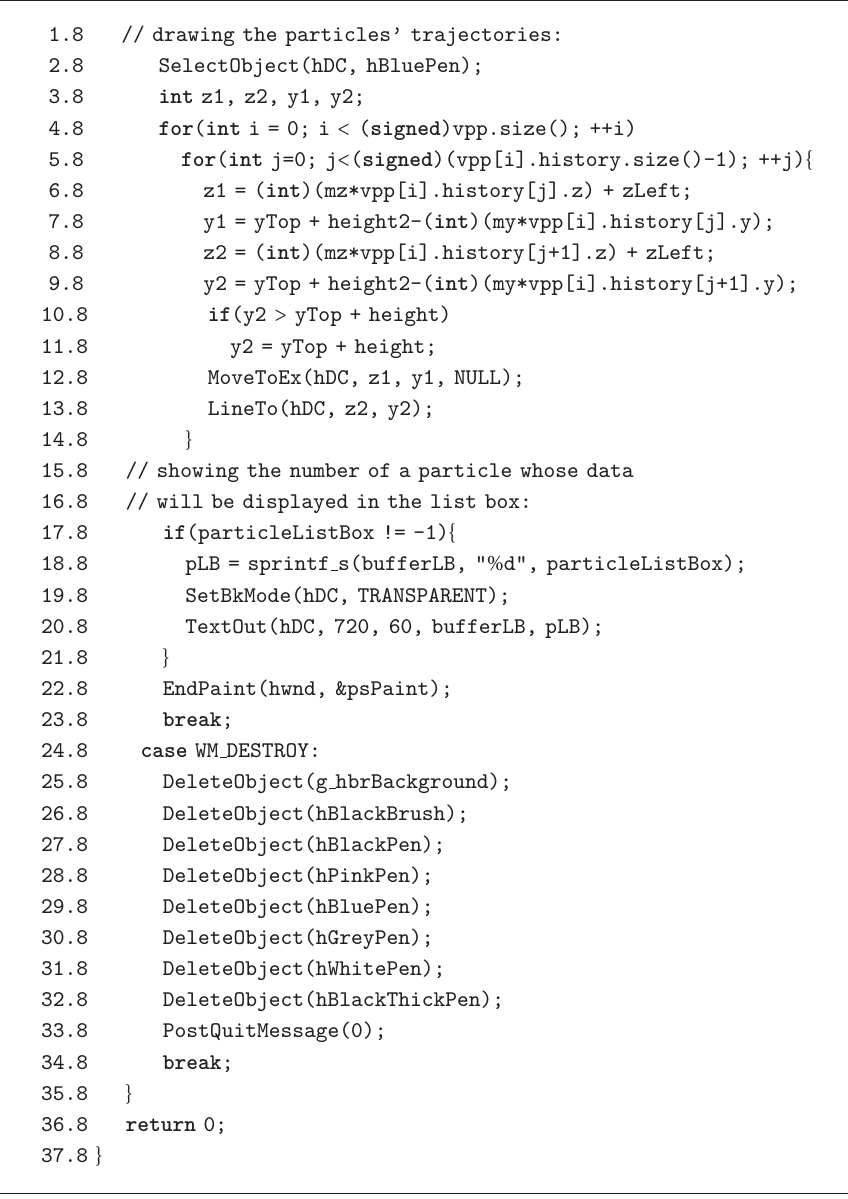
Algorithm 8: Modal dialog box: function ModalDlgProc (part